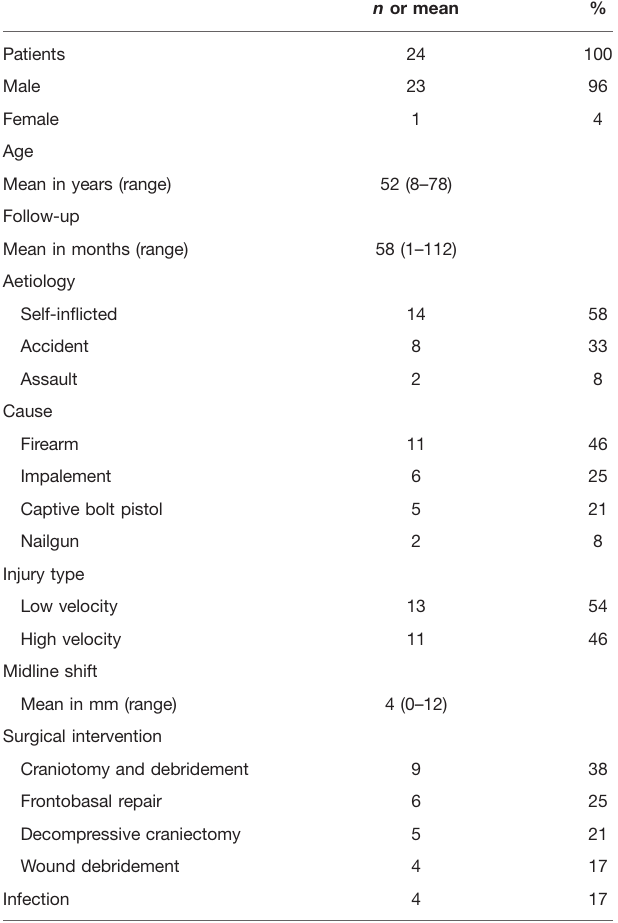
TABLE 1 | Patient